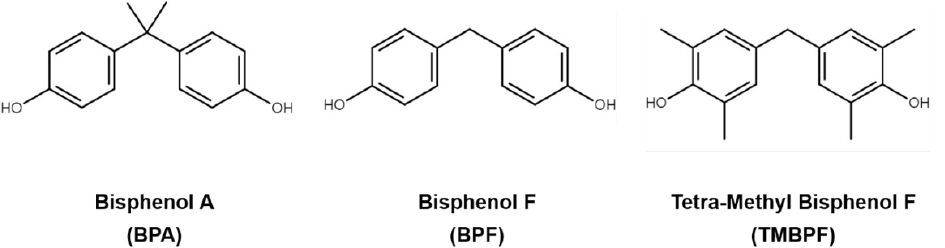
Figure 1. Chemical structures of bisphenol A (BPA) and its substitutes, bisphenol F (BPF) and tetramethyl bisphenol F (TMBPF).